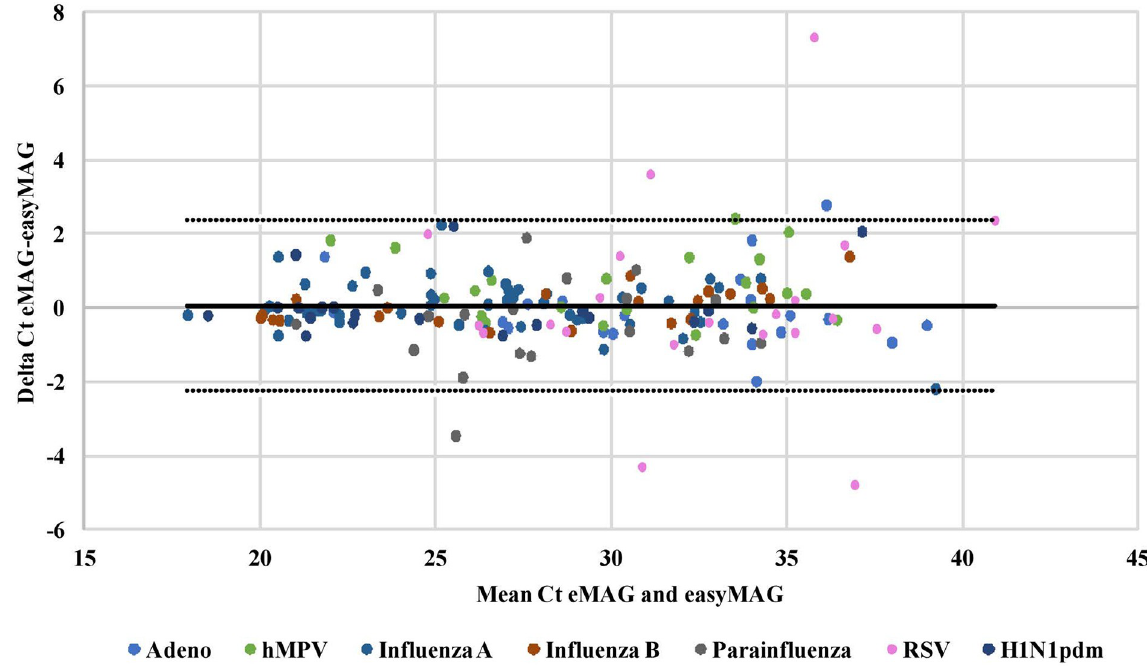
Fig 2. Bland-Altman analysis of the quantitative results of eMAG versus easyMAG. Bland-Altman analysis was performed on all samples for all the viruses examined, to compare the Ct values measured between eMAG and the easyMAG. The y-axis presents the delta Ct between the two platforms, while the x-axis presents the mean Ct value for both platforms for each sample. 2 SD borders are shown.